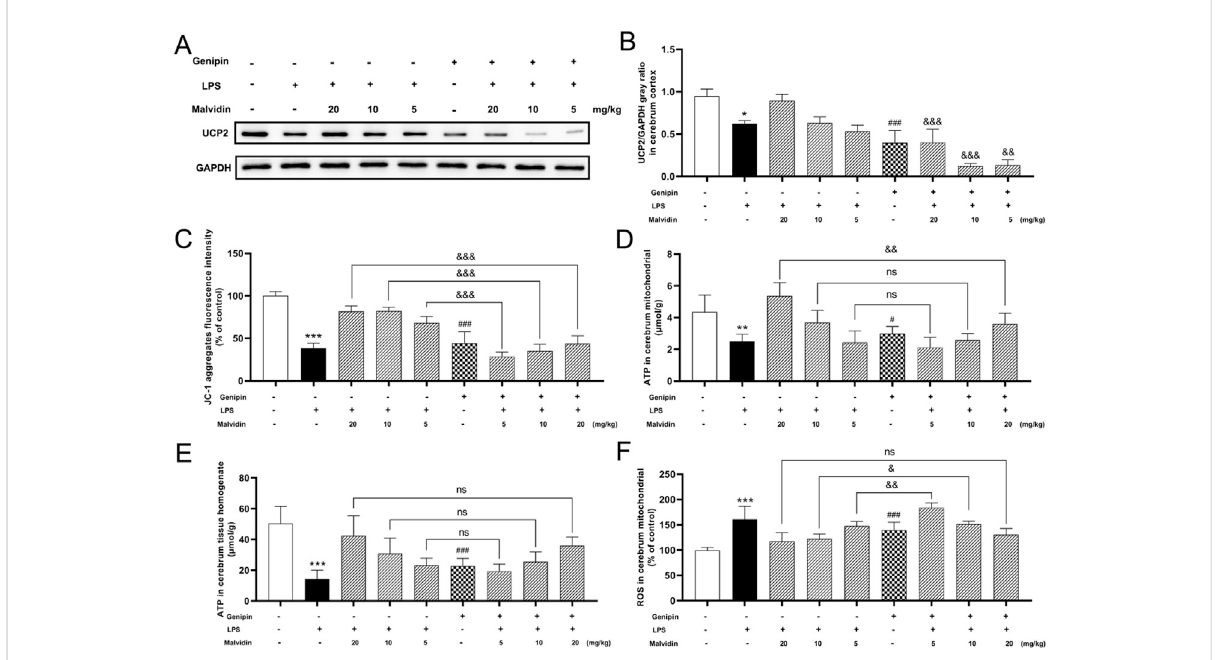
Inhibition of UCP2 on MMP changes, ATP production, and ROS release in malvidin pretreated LPS stimulated mice. Mice were gavaged with genipin prior to LPS injection. (A) UCP2 protein expression levels in the cerebrum tissues were detected using immunoblotting assays. GAPDH was usedasaninternalreference. (B) GrayratioanalysisofUCP2/GAPDHin (A) usingImageJandexcelsoftware( n =3). (C) JC-1aggregates fl uorescence intensity in the puri fi ed cerebrum mitochondrial was detected using mitochondrial membrane potential assay kit ( n = 6). (D, E) ATP contents were measured both in the puri fi ed cerebrum mitochondrial and cerebrum tissue homogenates using ATP content assay kit ( n = 6). (F) ROS levels were detected in the puri fi ed cerebrum mitochondrial using ROS assay kit with fl uorescent probe H 2 DCFDA ( n = 6). * represents